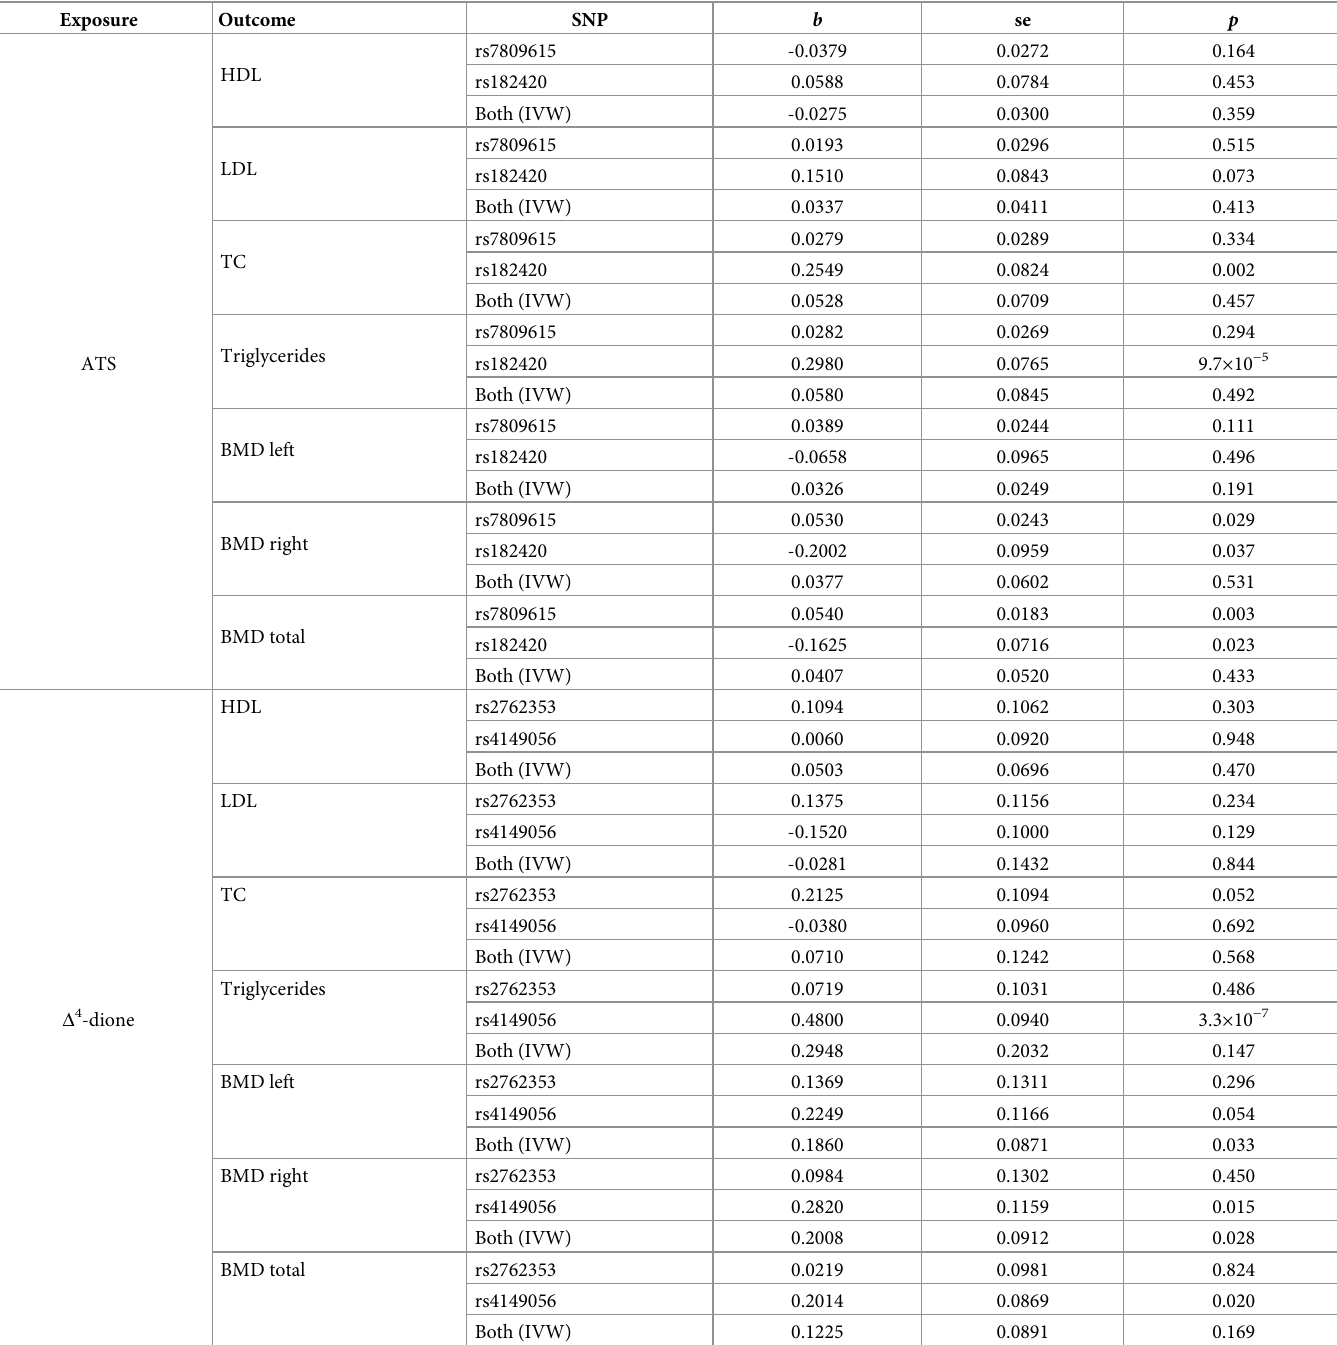
Table 6. MR tests for metabolite instruments on lipid and BMD outcomes. Exposure